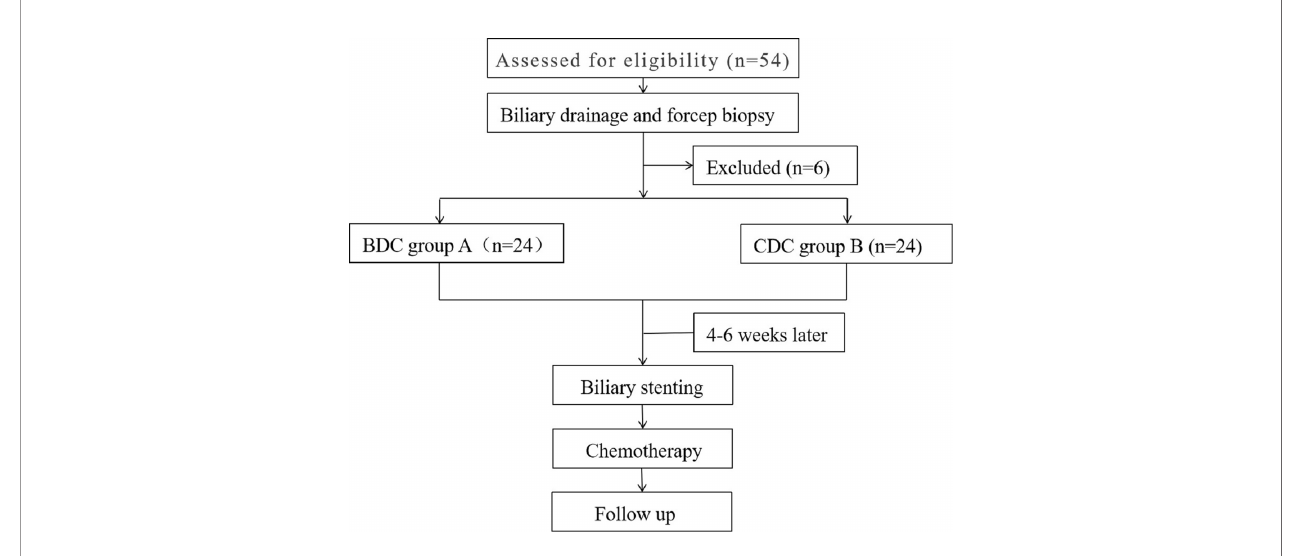
FIGURE 1 | Work fl ow of the